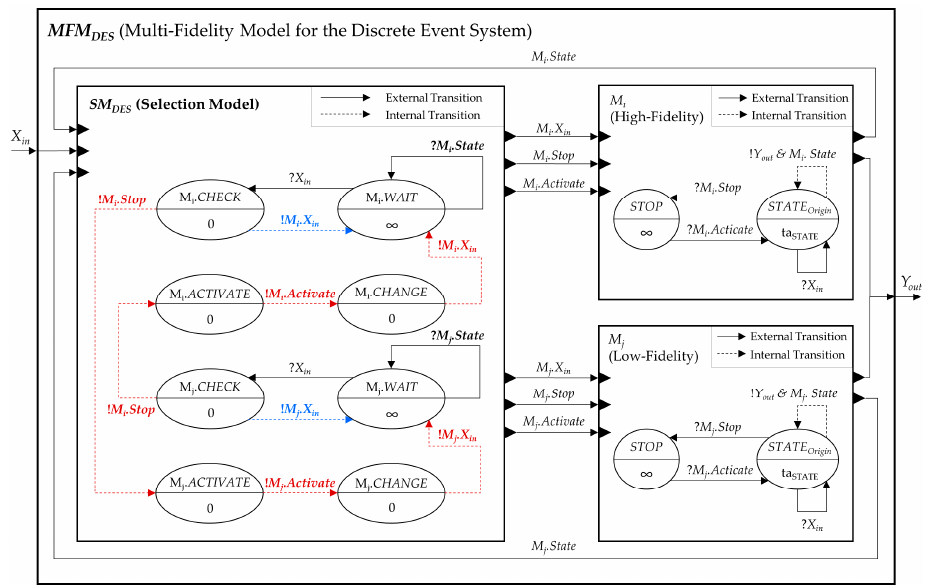
Figure 11. An example of the multi-fidelity model’s structure for a discrete event system: Fidelity-unchanged and fidelity-changed